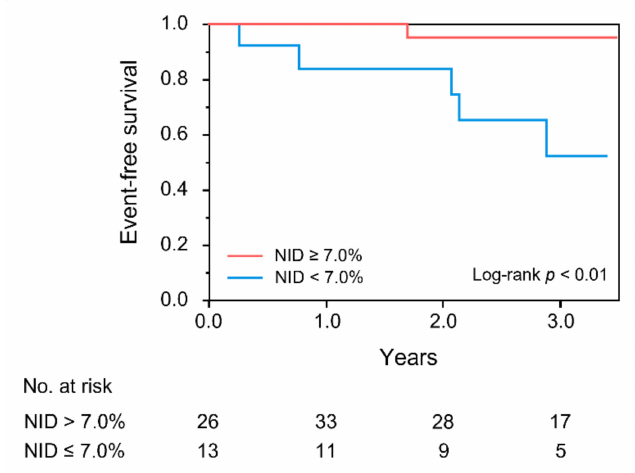
Figure 3. Kaplan–Meier curves of cumulative event-free survival of patients with heart failure with mildly reduced ejection fraction according to nitroglycerine-induced vasodilation (NID). The primary endpoint was deterioration of left ventricular ejection fraction (LVEF), defined as a decrease in LVEF to <40%. Table 4. Association between nitroglycerine-induced vasodilation and ejection fraction deteriorated during follow-up.